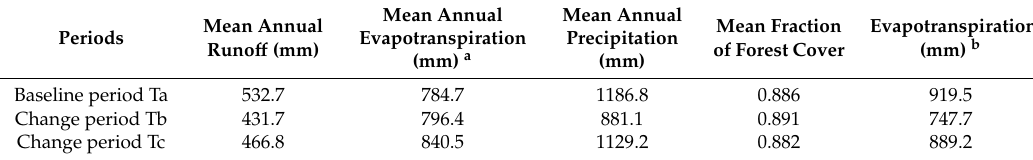
Table 3. Summary of the annual precipitation and runo ff in di ff erent periods.